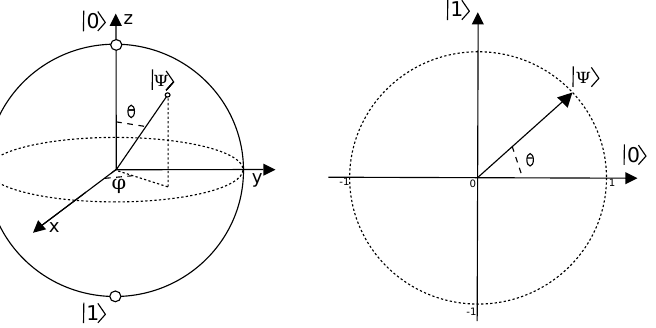
Figure 2. Representation of a qbit: On the left , the Bloch Sphere, a spherical representation of a qbit. On the right , a circular representation of a qbit after all the